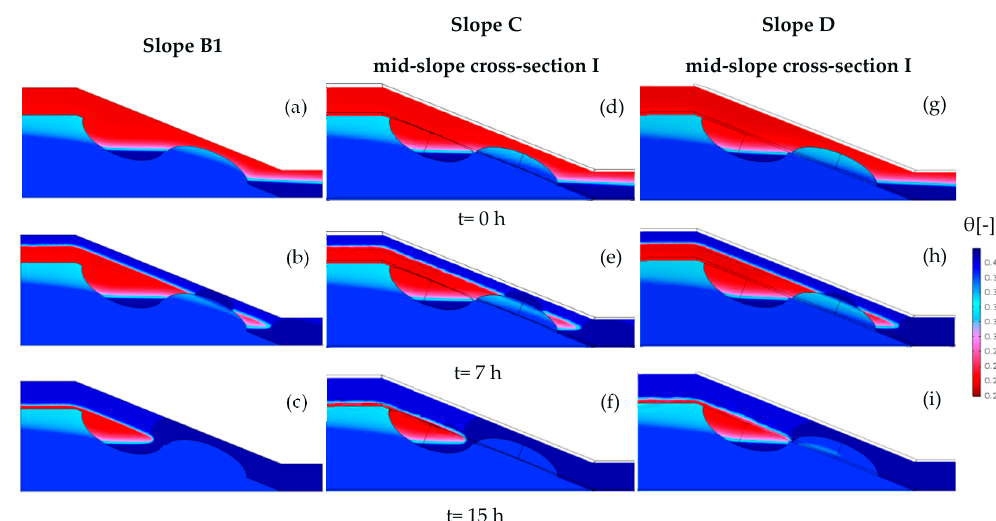
Figure 14. The temporal development of soil water content of the 2D slope with variable bedrock topography (Slope B1) for ( a ) t = 0 h, ( b ) t = 7 h, and ( c ) t = 15 h, the mid-slope cross-section I of the 3D slope C for ( d ) t = 0 h, ( e ) t = 7 h, and ( f ) t = 15 h and the mid-slope cross-section I of the 3D slope D for ( g ) t = 0 h, ( h ) t = 7 h, and ( i ) t = 15 h after the start of the intensive rainfall event with 20 mm per year.